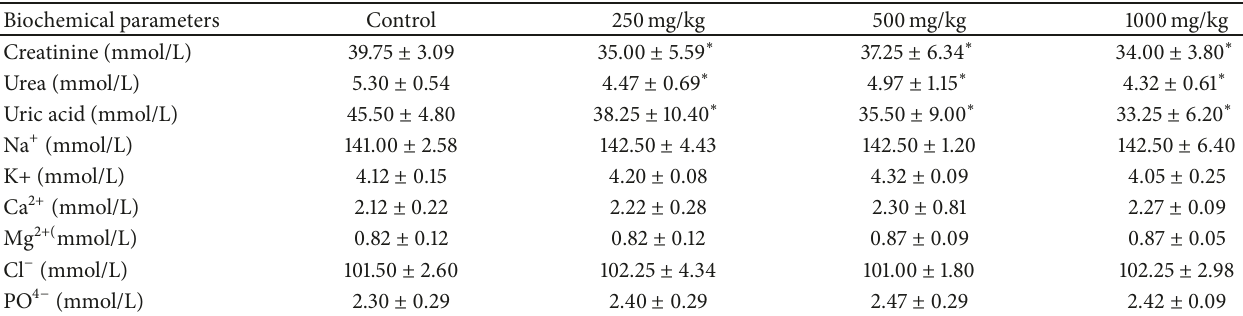
Table 6: The effects of different concentrations of pomelo methanolic extract on serum renal markers. Biochemical parameters